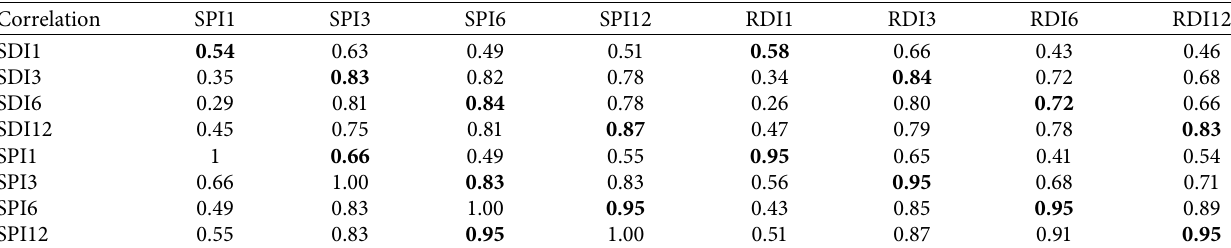
Table 8: Hydrometeorological drought index